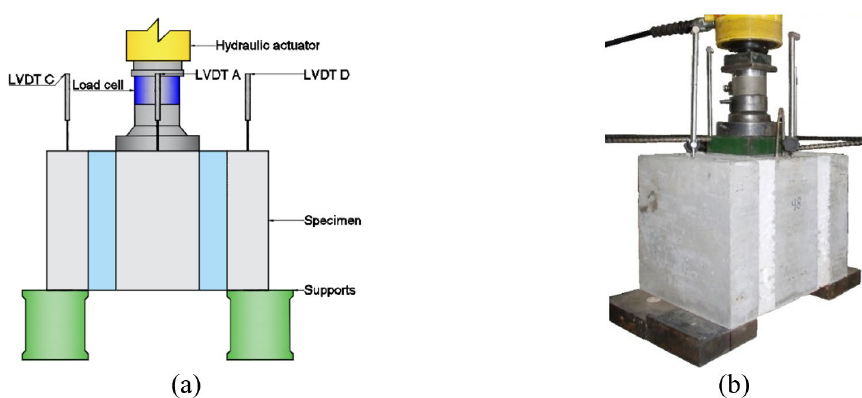
Figure 8: Push-out test: (a) schematic illustration; (b) test